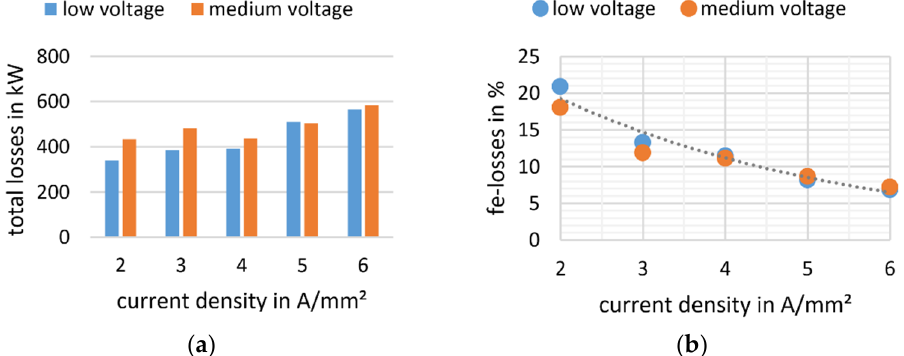
Figure 11. ( a ) Total iron losses depending to the current density; ( b ) Percentage iron losses to the total losses.